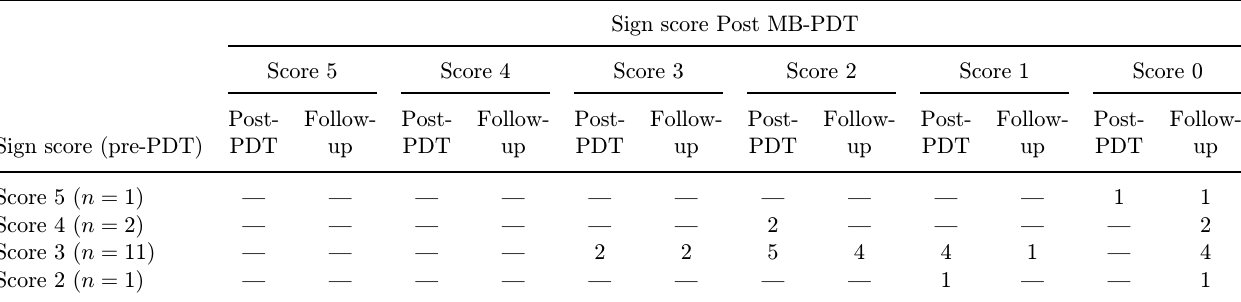
Table 2. Sign score of the OLP lesions at the pre-, post-treated and follow-up